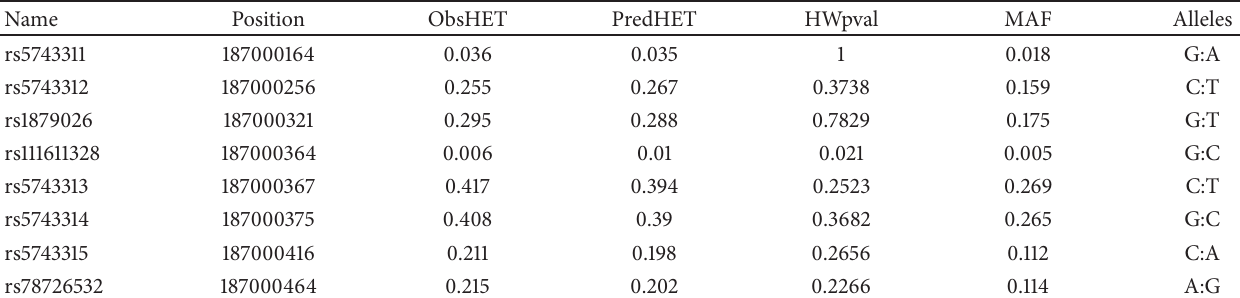
Table 2: Heterozygosity, HWE, and minor allele frequency of the TLR3